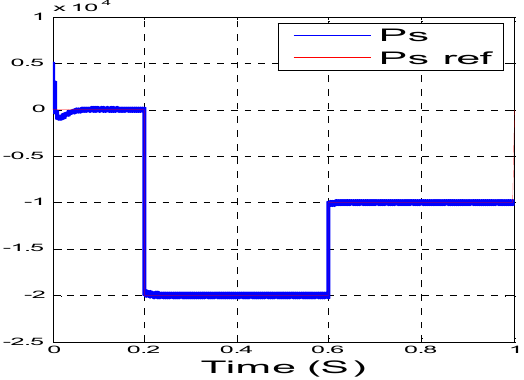
Figure 14. Active power stator.